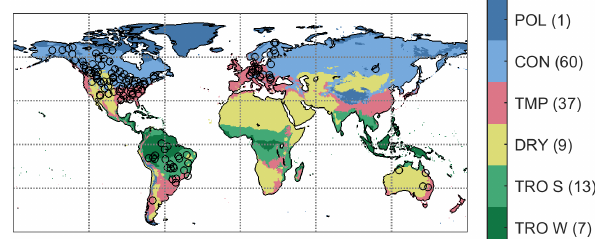
Figure 1. Map of the Köppen–Geiger climate classification and the GRDC stations used in this study. The number of GRDC sta- tions within each climate type is included in the legend in